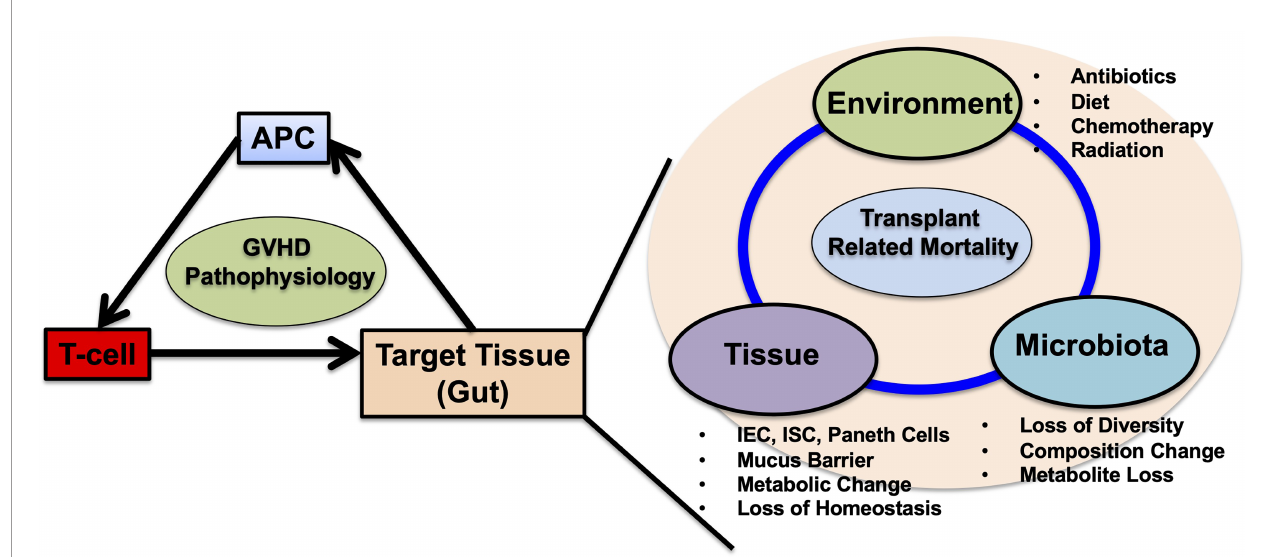
FIGURE 3 | Schematic representation of acute GVHD pathophysiology and the multifactorial interactions in the gut target tissue. Historically, antigen presenting cells (APCs), donor-T cells and target tissues are the main factors in acute GVHD pathophysiology. Among these cells, APCs and T-cells are well studied and targeted for GVHD prevention and treatment. In gut GVHD, microbial dysbiosis are highly associated with transplant related mortality. Microbial dysbiosis is one aspect of multifactorial interactions in the gut during GVHD. In HSCT, conditioning regimens including chemotherapy and irradiation cause damages to intestinal epithelial cells (IECs), intestinal stem cells (ISCs), paneth cells mucus producing goblet cells. Disruption of gut microbiota already exists before HSCT, and prophylactic and systemic antibiotic treatments worsens the microbial dysbiosis with loss of diversity, composition changes along with increase of Enterococcus . Dysbiosis depletes microbial derived metabolites changes the IEC metabolism skewing to less tolerant against donor T-cell damages, postpones IEC repairs and mucus barrier restorations. Expansion of Pathogenic bacteria permits blood stream infection thorough injured IECs that necessitate systemic antibiotic administration, leading to further microbial disruptions. These factors including environment, tissue and microbiota falls into the vicious cycle leading to transplant related mortality. The questions remain whether which factor could be prioritized and be targeted for treatments including fecal microbiota transplantation (FMT), prebiotics, probiotics, the attentions of the usages of anti-anaerobic antibiotics and other interventions targeting tissues. Single or combined strategies are warranted to break the vicious cycle and improve HSCT